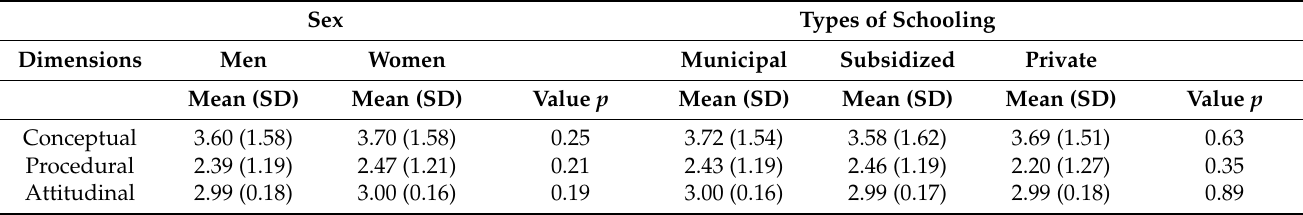
Table 6. Results for the conceptual, procedural and attitudinal dimensions disaggregated for the students’ sex and type of schooling. Types of